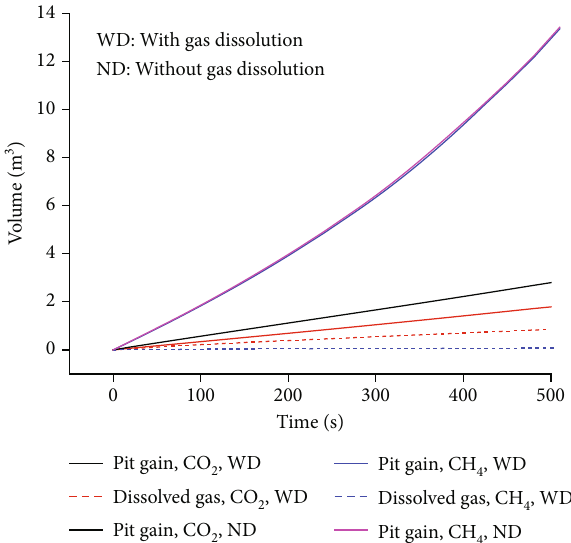
Figure 8: Comparison of the pit gain at di ff erent times during methane and CO 2